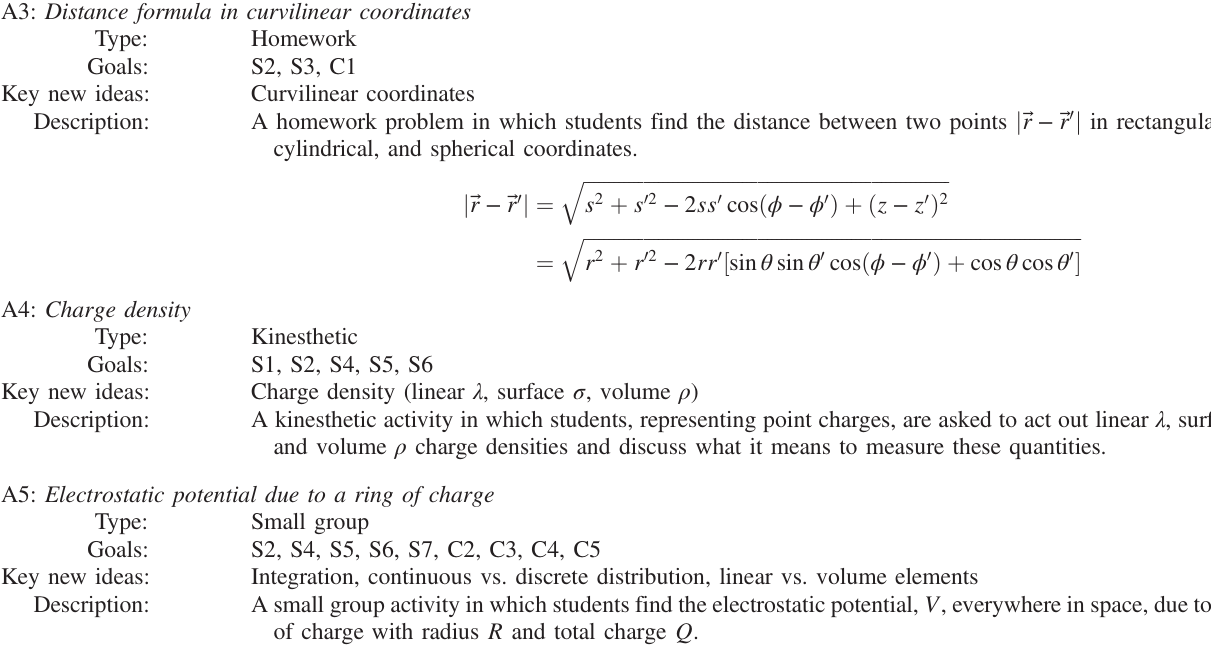
A3: Distance formula in curvilinear coordinates Type: Homework Goals: S2, S3, C1 Key new ideas: Curvilinear coordinates Description: A homework problem in which students find the distance between two points j ⃗ r − ⃗ r 0 j in rectangular, cylindrical, and spherical coordinates.